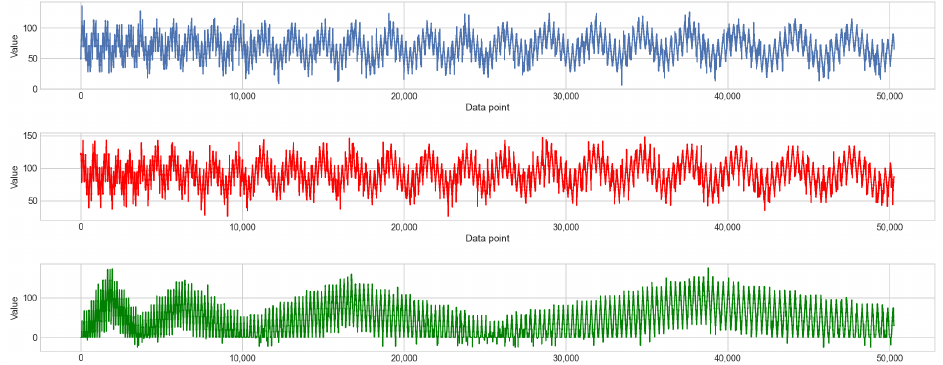
Figure 8. Visualisation of the training set with artificial